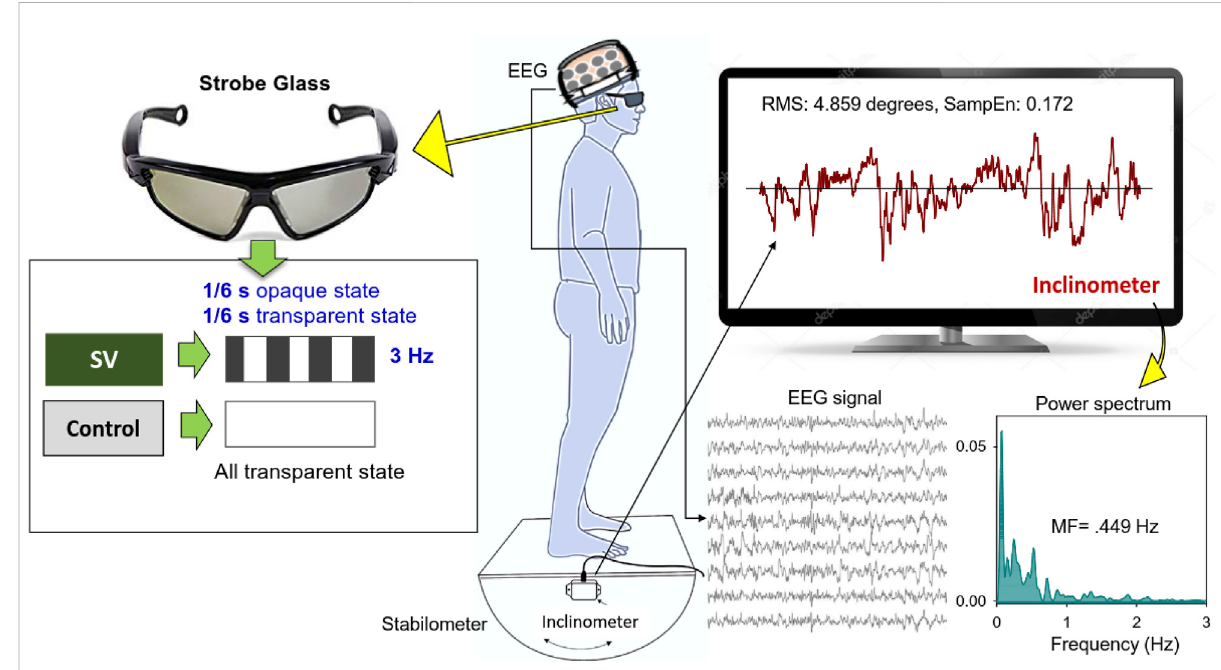
FIGURE 1 System setup and stabilometer stance with and without stroboscopic vision (SV). Under SV, the subjects regulated upright stance on the stabilometer with intermittent visual feedback of stabilometer movements at 3 Hz. In the control condition, the subjects wore stroboscopic glasses and visually tracked the stabilemeter movement trajectory with full